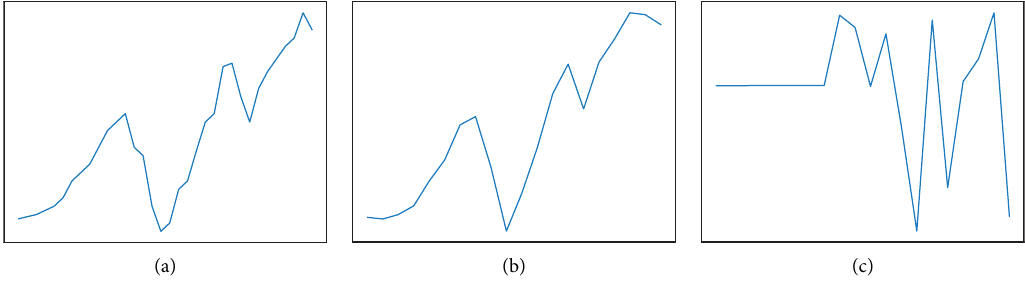
Figure 1: (a) A time-series instance, (b) the corresponding low-frequency components, and (c) high-frequency